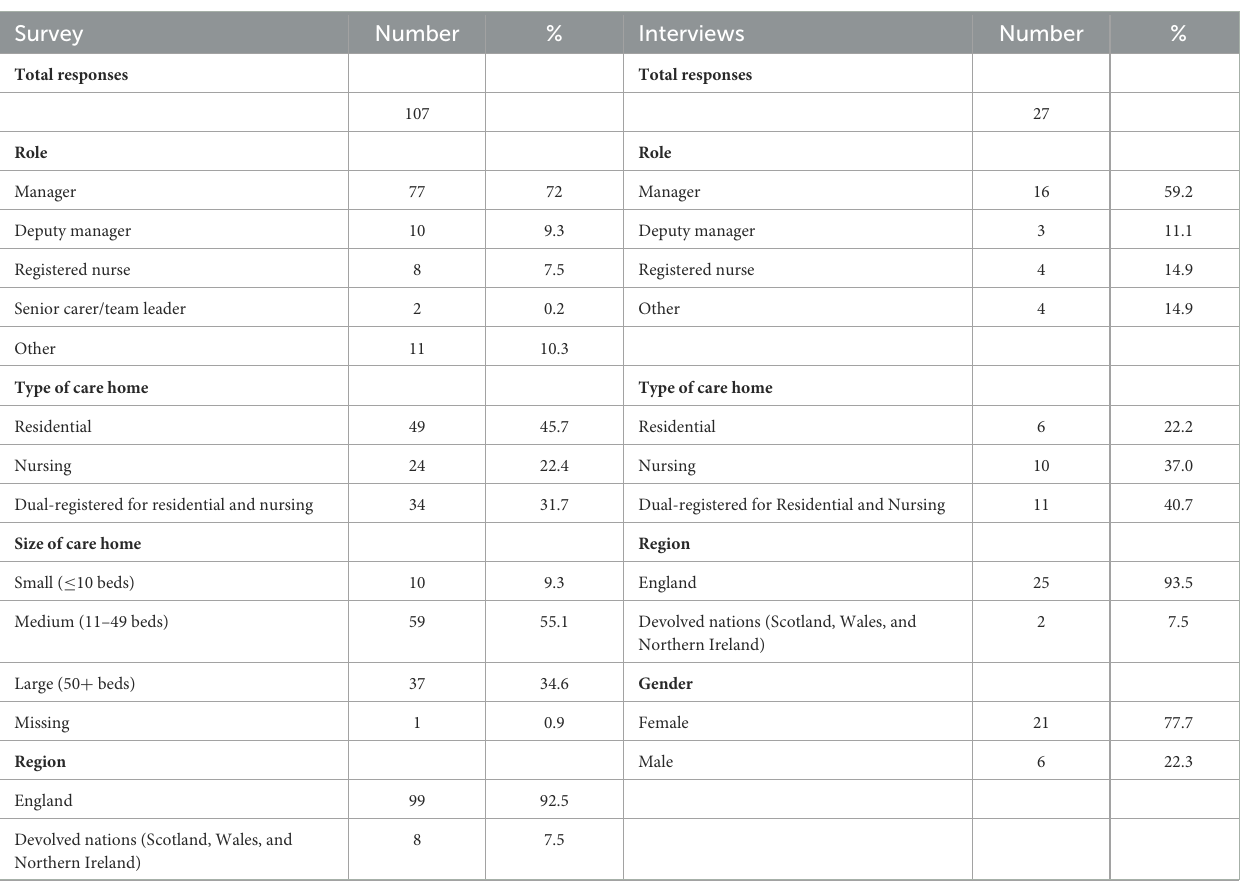
TABLE 1 Survey respondent and interview participant